Question: What style of plot is this figure drawn as?
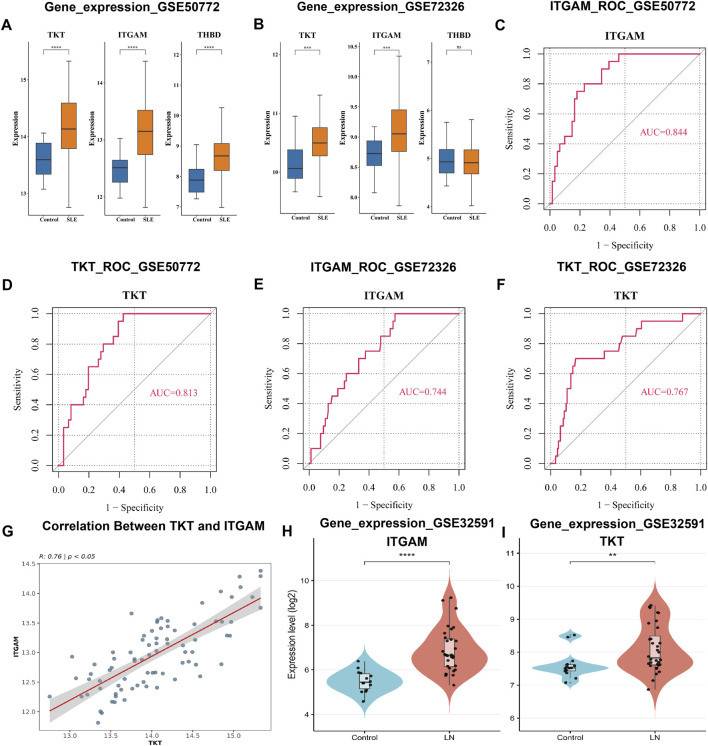
Answer: scatter